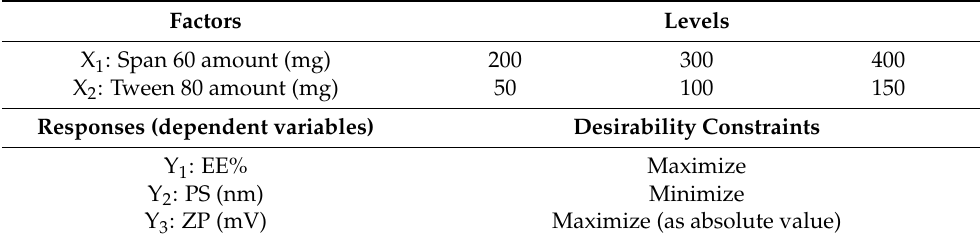
Table 1. Full 3 2 factorial design for TOL basic spanlastics optimization. Factors